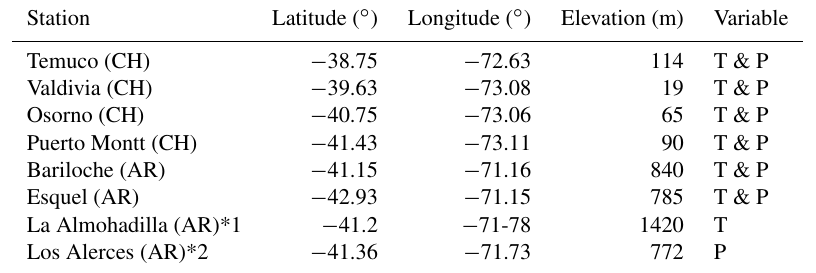
Table 3. The surface stations used to create the regional climate series. CH is Chile, AR is Argentina, T is temperature, P is precipitation. *1 La Almohadilla is the closest temperature record to Monte Tronador. *2 Los Alerces the closest precipitation record to Monte Tronador.